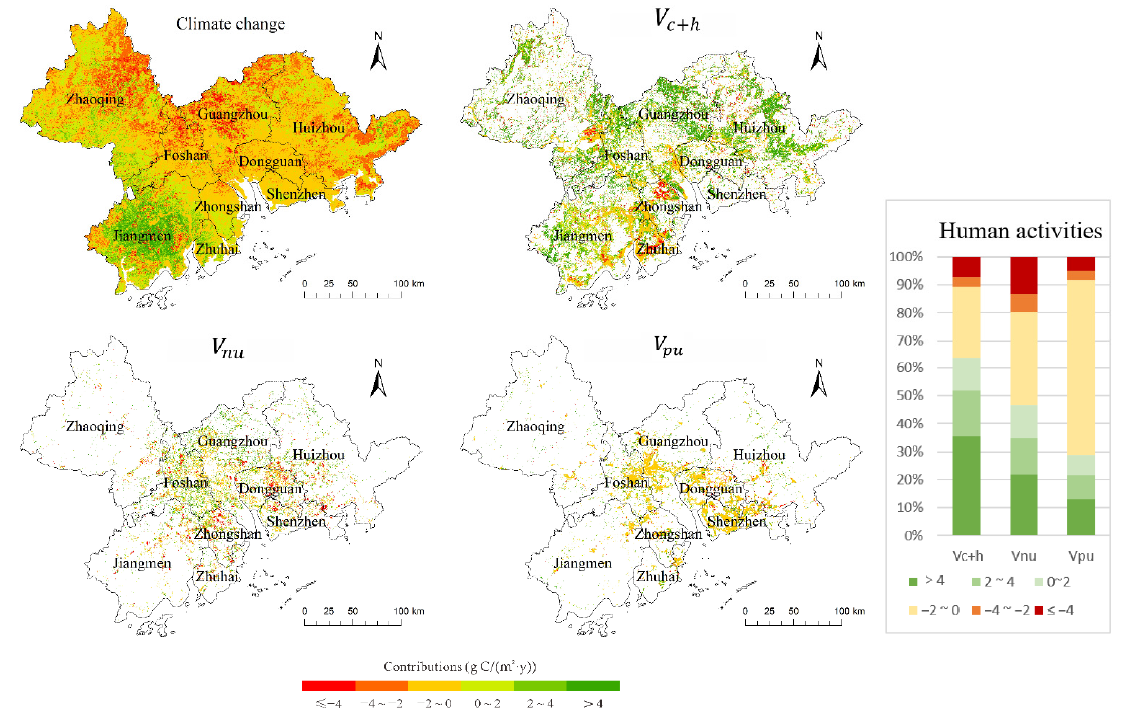
Figure 7. Contributions of human activities and climate change to net primary productivity (NPP). The results indicate that the contribution of climate to NPP was mainly negative be- cause changes in solar radiation, precipitation, and temperature were not conducive to vegetation growth in most areas of the PRD during the study period. In the regions af- fected by both climate and human activities, the positive contribution of human activities outside urban land to NPP was greater than that of urban land. The NPP of most areas inside urban land was disturbed by human activities and showed a decreasing trend, and the impact of human activities on the NPP of new urban land was more severe. 3.3. Decoupling Index of Socioeconomic Factors and Carbon Sequestration Service Capacity The complex urbanization process and human activities are quantified by POP, NTL, and GDP. The decoupling relationship between these three social and economic factors and NPP is shown in Figures 8 and 9 to reflect the dependence of urban development on NPP.